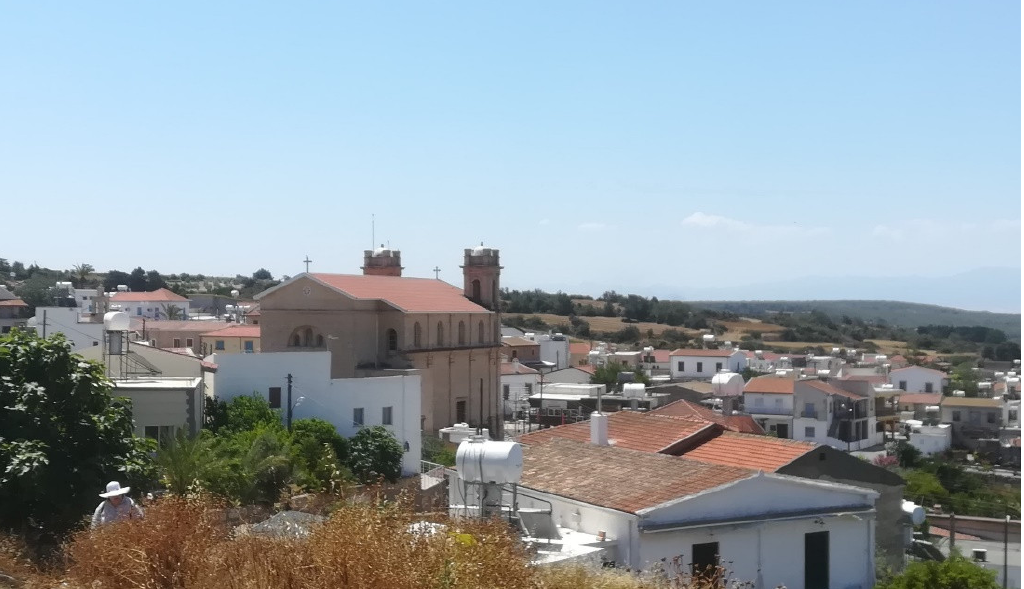
Figure 2. View of Kormakitis.